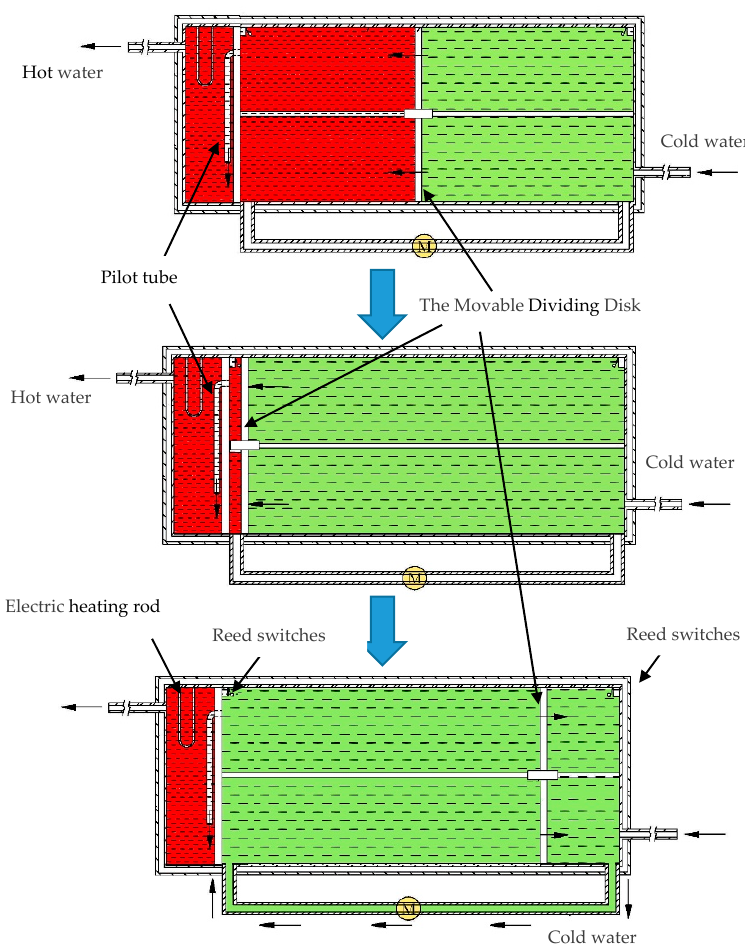
Figure 8. The moving process of dividing disks of the 4th generation solar water heating tank.